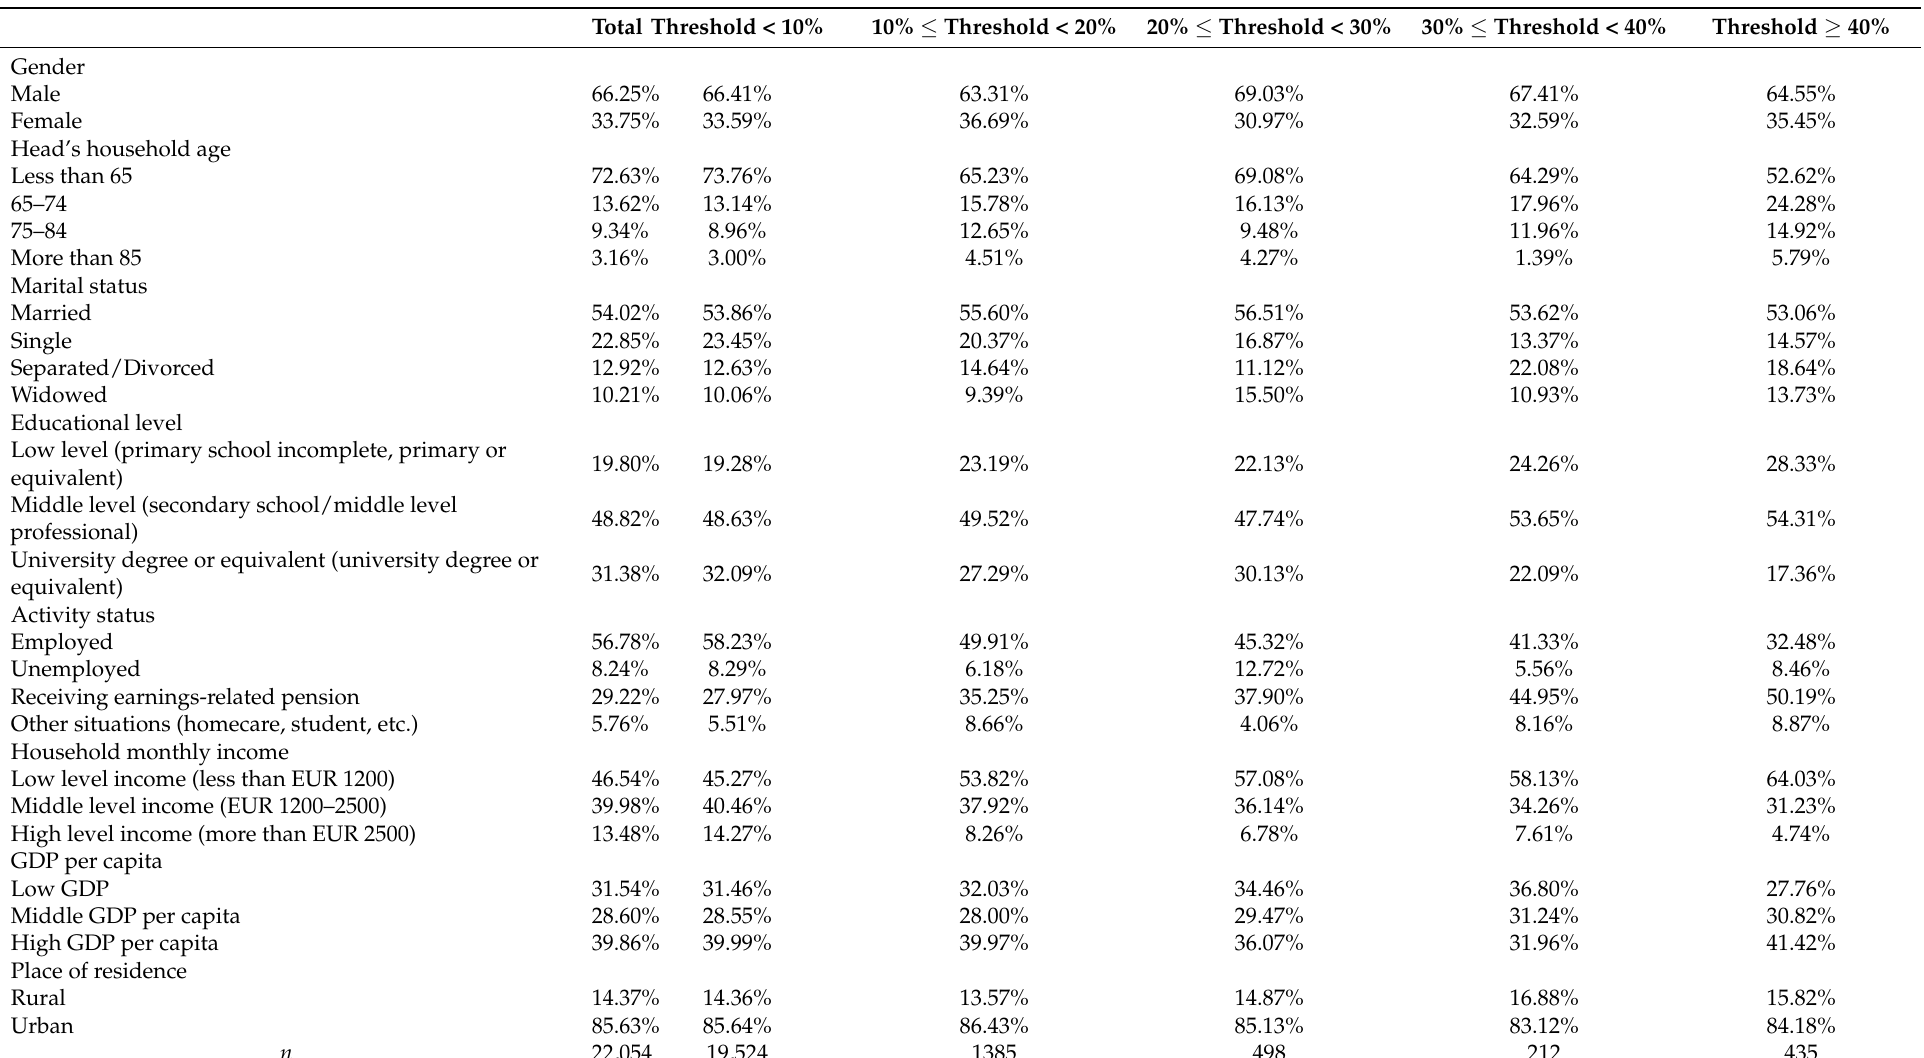
Table 3. Descriptive statistics of the sociodemographic variables of households in Spain based on the percentage of resources they dedicate to health payments. Year